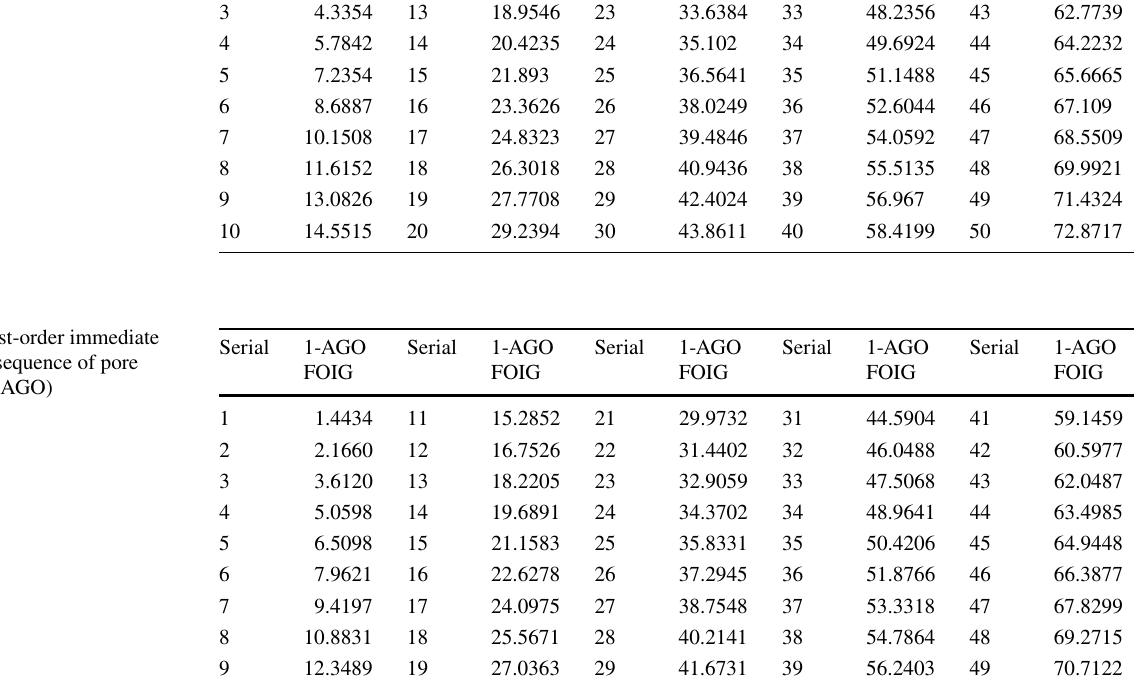
Table 3 First-order cumulative generating sequence of pore pressure